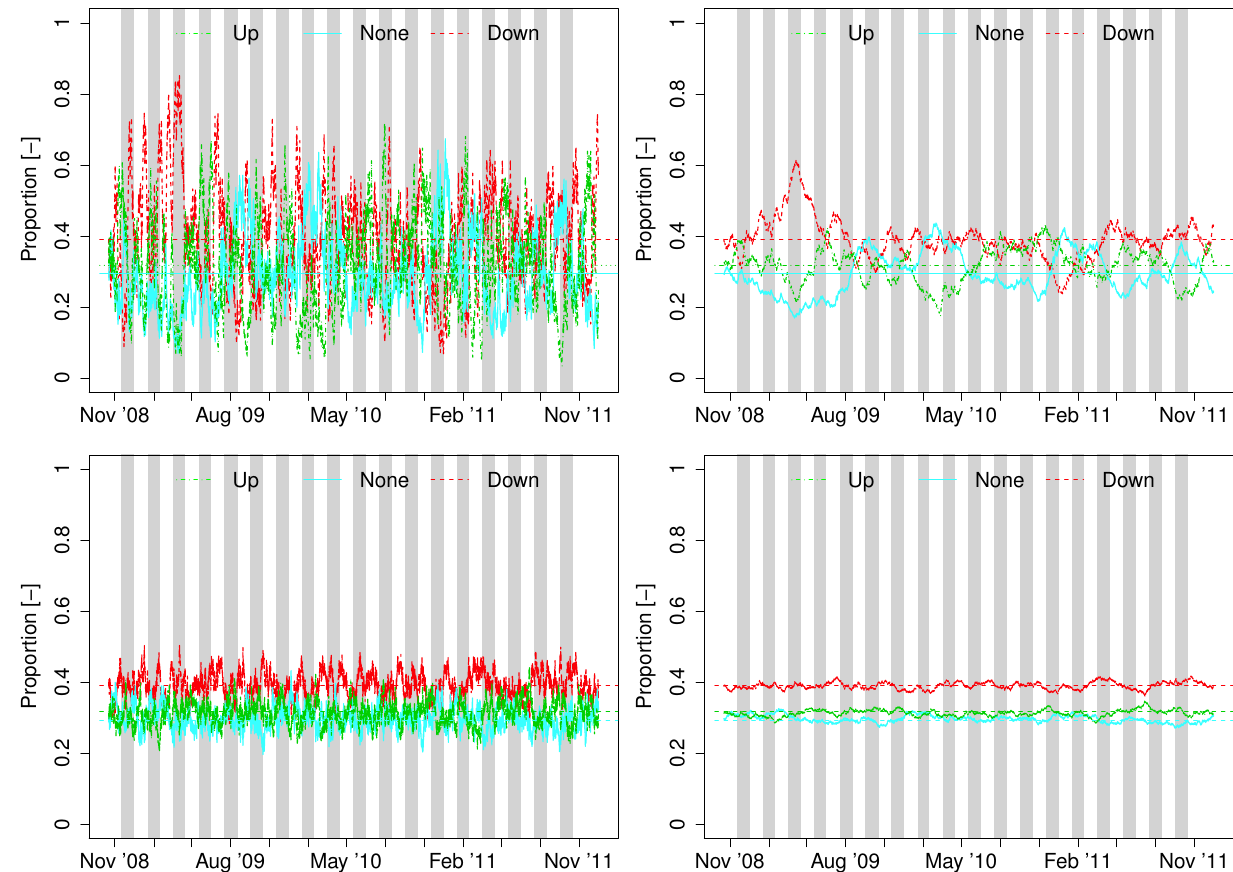
Figure 2. Exponentially smoothed state probabilities of the observed I ( ↑ / ↓ ) ( top row ) and the simulated I ( ↑ / ↓ ) ( bottom row ) with λ = 0 . 99 ( left column ) and λ = 0 . 999 ( right column ). The horizontal lines represent the empirical probabilities for the whole